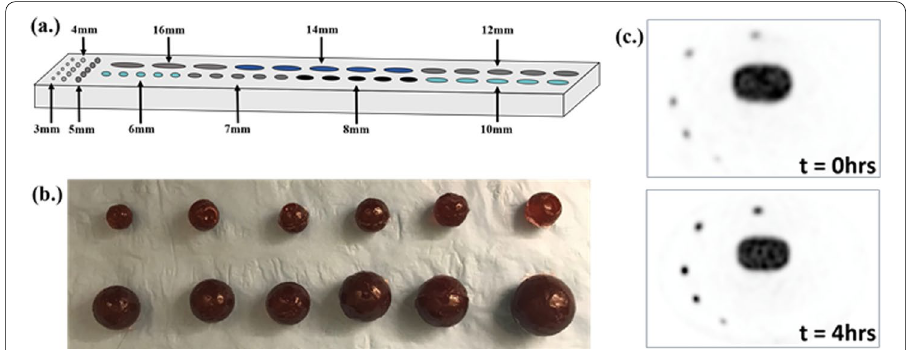
Fig. 2 Sodium-22 epoxy spheres. a Schematic of aluminium mould used for casting 3–16-mm spheres. b Radioactive epoxy spheres (3–16 mm) infused with 22 Na-NaCl. c Transaxial PET image slices of Probe-IQ